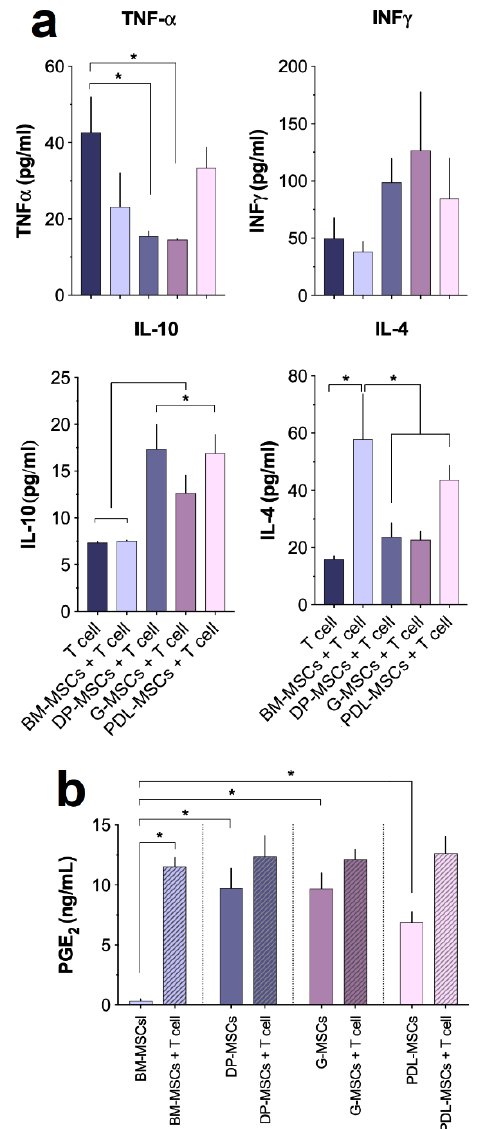
Figure 5. Molecule expression is di ff erentially induced in co-cultures with MSCs from BM and dental tissues. CD3 + T-cells activated with anti-CD3 / CD28 were cultured in the presence or absence of BM-MSCs or DP-MSCs or G-MSCs or PDL-MSCs at a 1:1 ratio of MSCs:T-cells. After four days of co-culture, TNF α , IFN γ , IL-10, and IL-4 were determined in the conditioned medium by cytometric bead array and PGE 2 by ELISA. ( a ) The concentration of cytokines detected in the conditioned medium of CD3 + T-cells in the absence of MSCs was considered as basal expression for tumor necrosis factor alpha (TNF α ), interferon (IFN) γ , interleukin (IL)-10 and IL-4, ( b ) while for PGE 2 , these were the concentrations detected in the conditioned medium of MSCs cultured in the absence of CD3 + T-cells. The data are presented as the mean ± SEM of the concentrations of the analyzed molecules (n = 5, individual experiments). * Significant di ff erence at p < 0.05. PGE 2, prostaglandin E 2 ; ELISA, enzyme-linked immunosorbent assay.